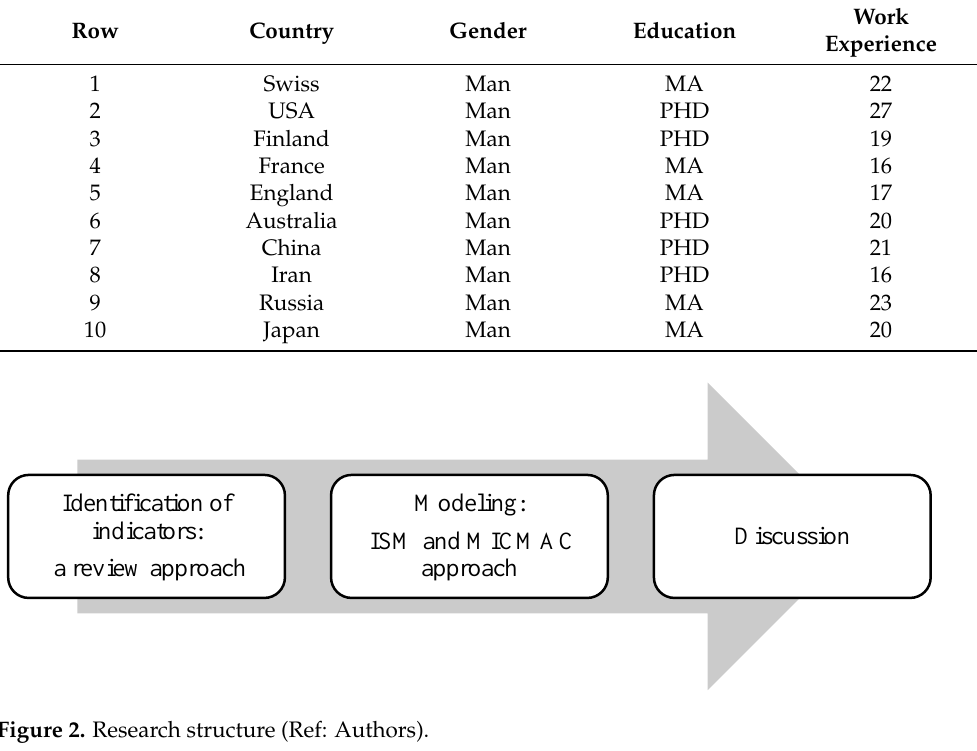
Table 5. Classification of indicators from the perspective of experts (Ref: Authors).